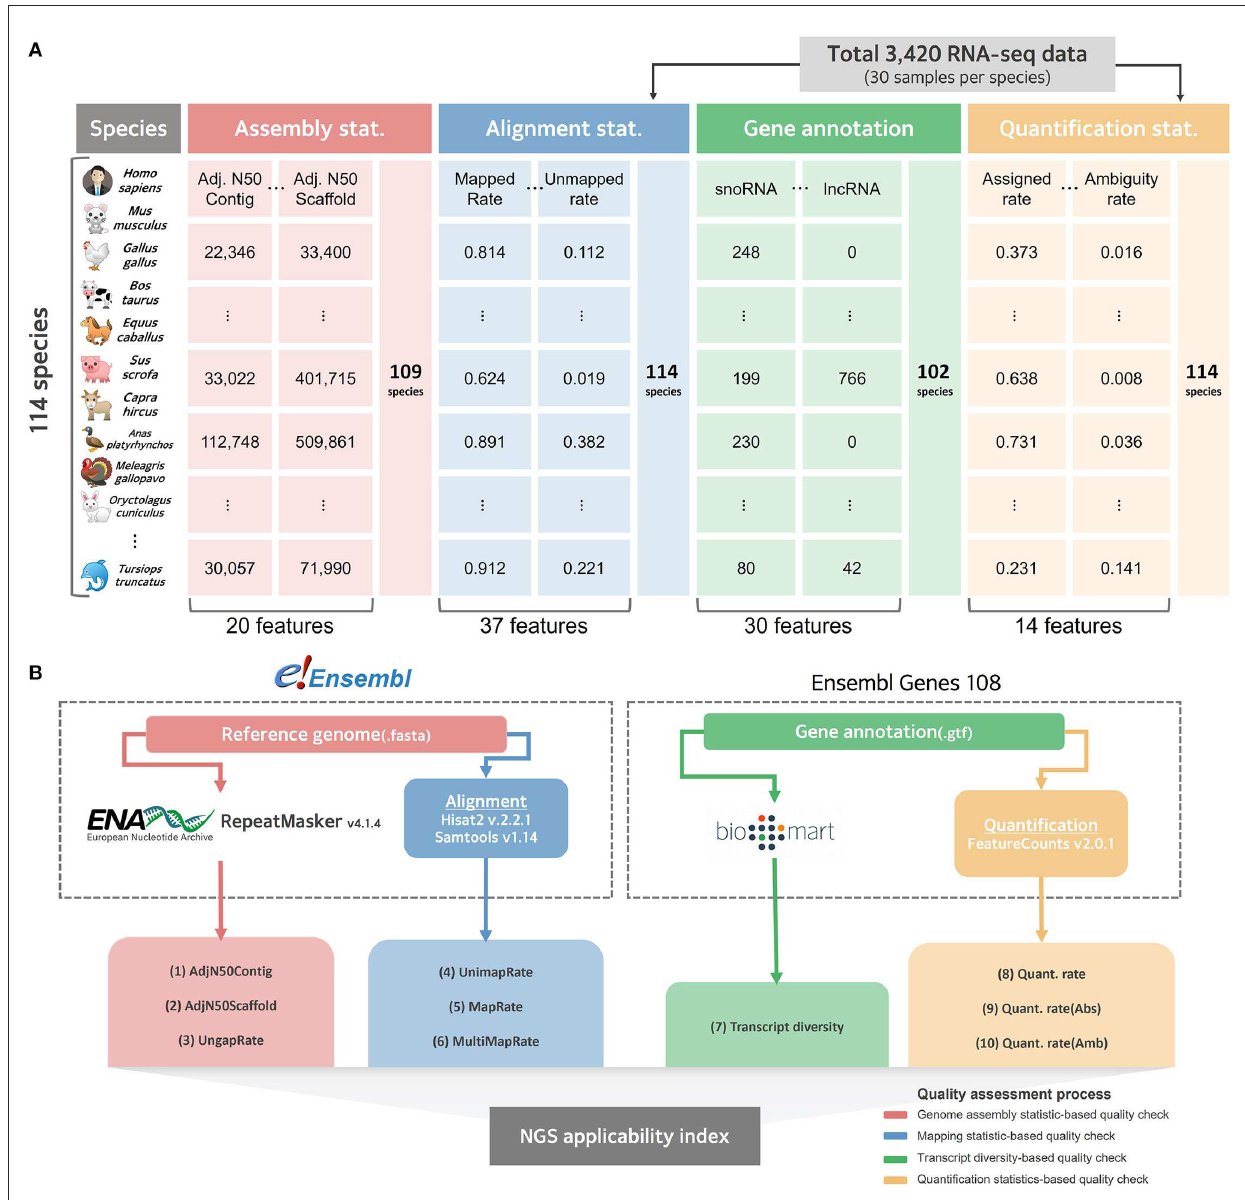
FIGURE1 Collected data structure and schematic diagram for benchmarking comparison. (A) Overall structure of data collected for quality evaluation of reference genome and gene annotation for 114 species. (B) A systematic workflow to select effective indexes for relative quality assessment from collected data. The red line represents a pipeline that selects effective indicators from assembly statistics for relative evaluation of the reference genome. The blue line represents the process of empirically evaluating the quality of the genome by mapping the actual NGS data in the alignment step. The green line represents the process of calculating the transcript diversity index, and the yellow line represents the pipeline that empirically finds effective indicators for quality evaluation of gene annotations in the quantification